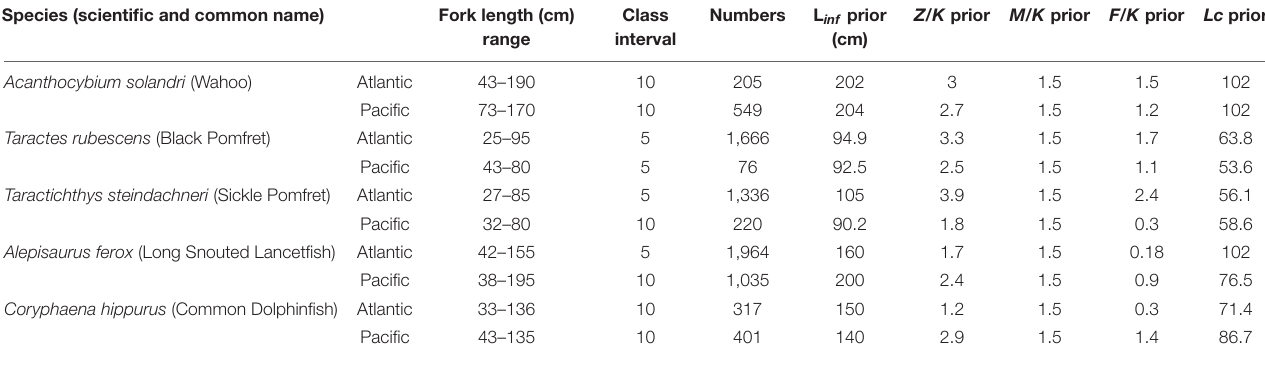
TABLE 1 | Basic information and priors of five small pelagic species from the Atlantic and Pacific Oceans used in the present study. Species (scientific and common